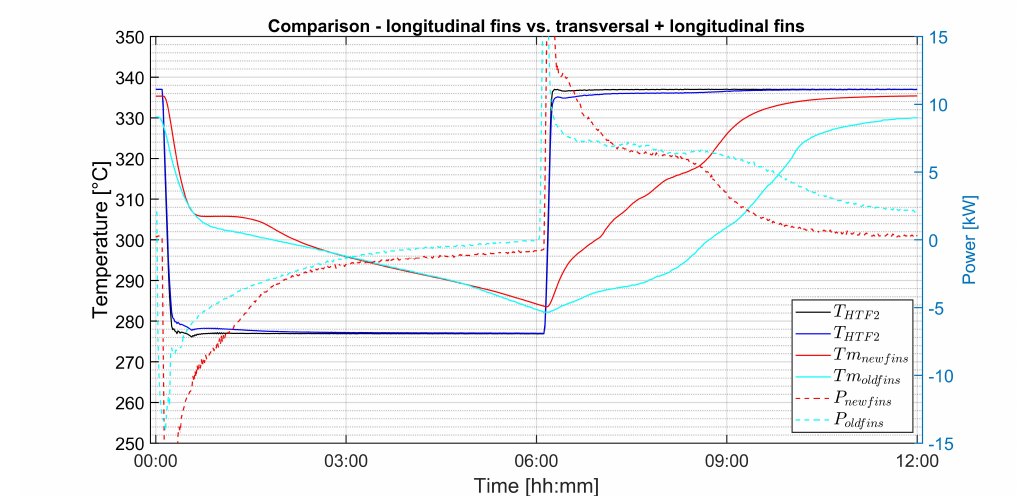
Figure 10. Comparison of different fin types.